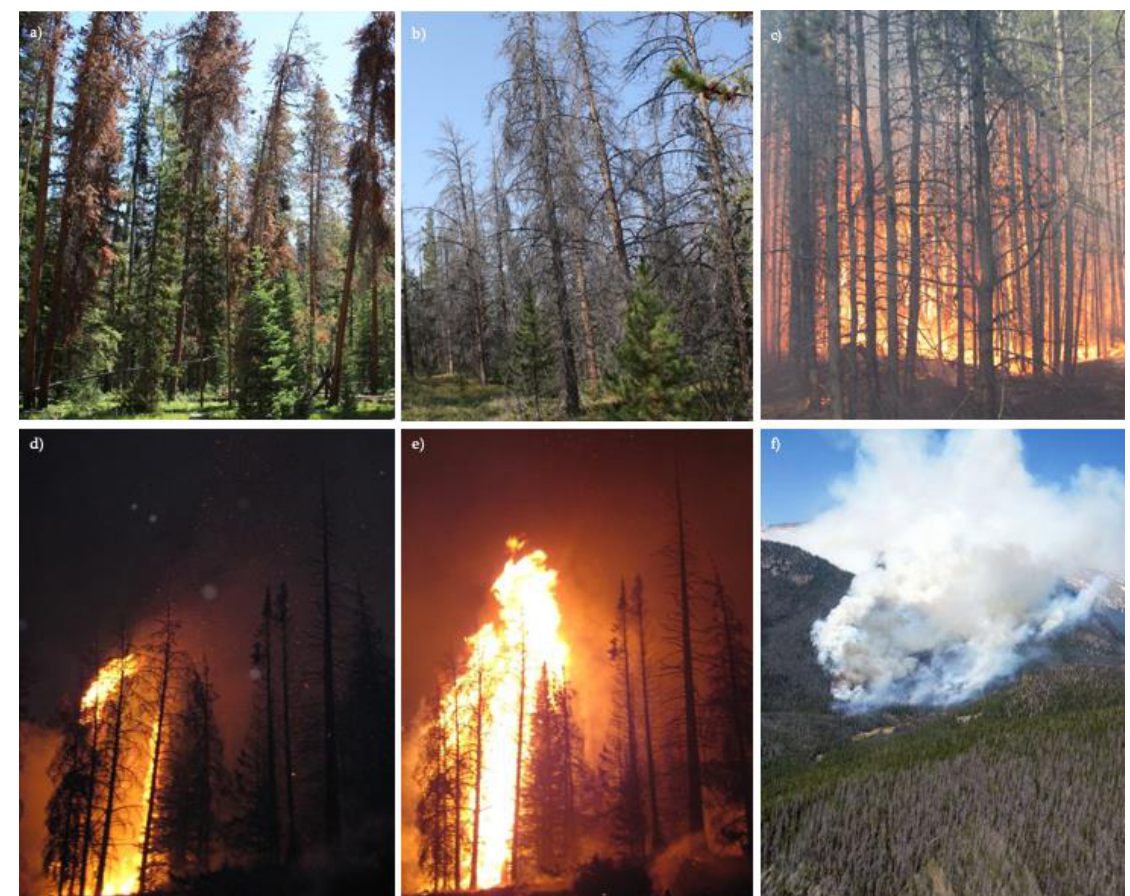
Figure 2. Examples of photos used during interviews with wildland firefighters. ( a ) red phase of MPB-attacked lodgepole pine forest, Colorado State Forest State Park (photo: Tony Cheng); ( b ) grey phase of MPB-attacked lodgepole pine forest, Fraser Experimental Forest (photo: Tony Cheng); ( c ) Wheeler Fire (photo: Southern Rockies Fire Module, The Nature Conservancy); ( d , e ) Church Park Fire (photo: National Interagency Fire Center InciWeb); ( f ) Big Meadow Fire, Rocky Mountain National Park (photo: National Park Service).